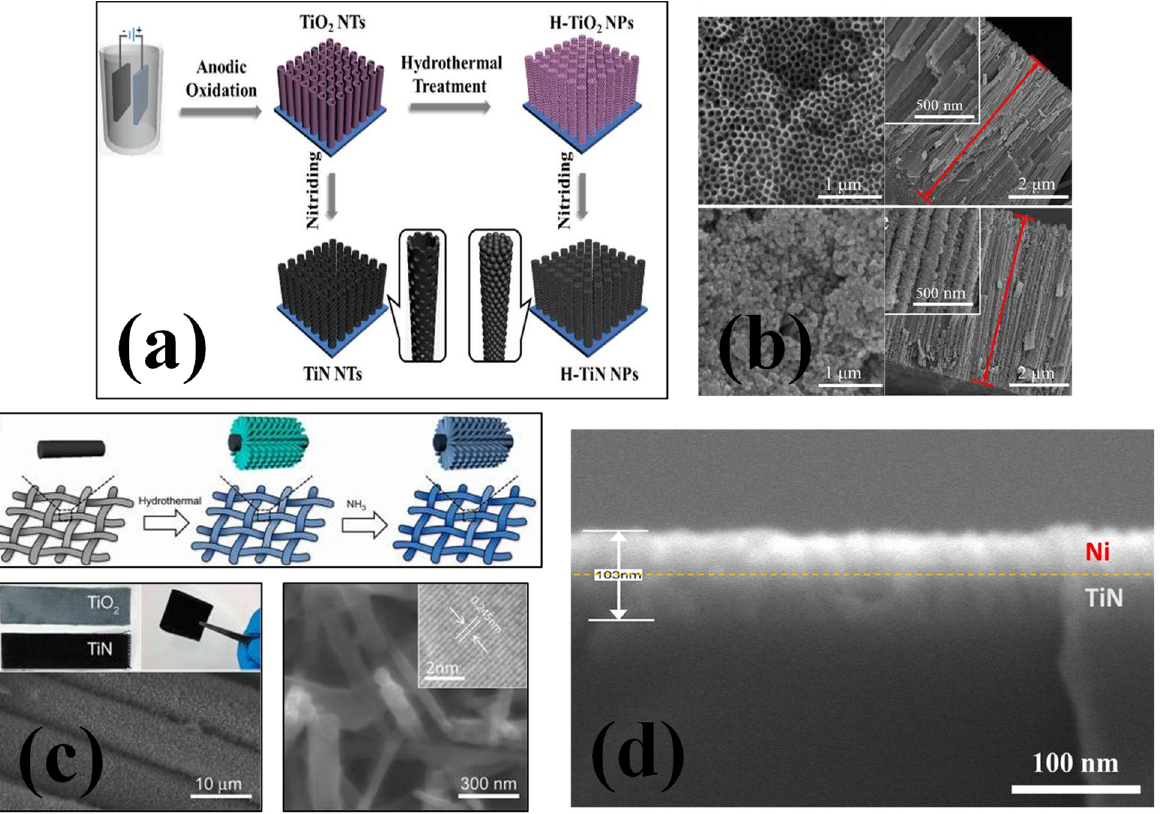
Figure 2. ( a ) The synthesis mechanism and ( b ) SEM images from different surfaces for TiN nan- otubes and H-TiN nanopillars [52], reproduced with permission, copyright 2013, Royal Society of Chemistry. ( c ) Schematic diagram illustrating the synthesis process for TiN nanowires grown on carbon cloth substrate and magnified SEM and TEM images of TiN nanowires [54], reproduced with permission, copyright 2012, American Chemical Society. ( d ) The SEM cross sectional image of